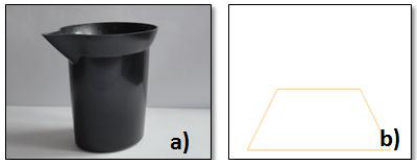
Figure 7. Glass flacon of perfumes number II: a) photo of the real objects; b) scanned cloud of points; c) scanned cloud of points after covering the object with chalk d) processed data in Multiple attempts of collecting the data in the form of black plastic water container showed that black objects cannot be scanned with the ground FabScan scanner. The reason is the fact that black does not absorb the laser beams (there is no reflection of the laser beam) (Fig. 8).